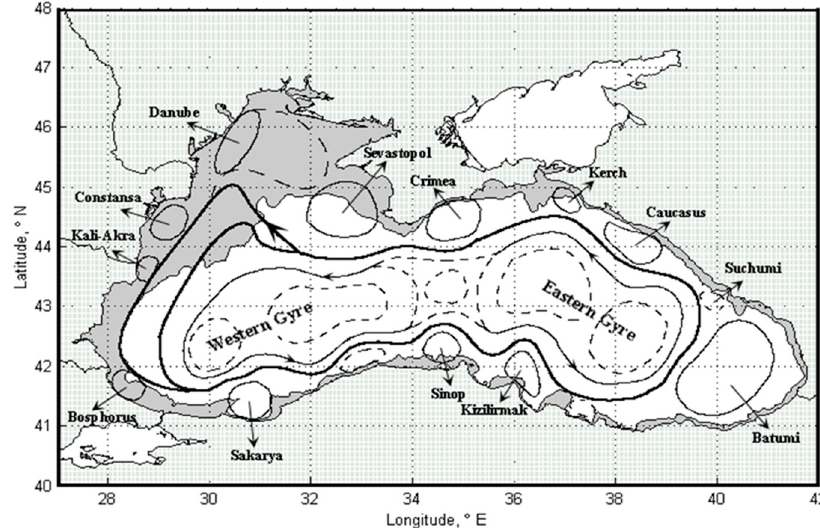
Figure 2. The general circulation in the Black Sea, adapted from Korotaev (2003)’s scheme. The circulation consists of two large gyres in the western and eastern parts of the sea, and a series of smaller (semi-permanent) eddies which are indicated by arrows. The shaded area represents shelf waters with depth less than 200 m.